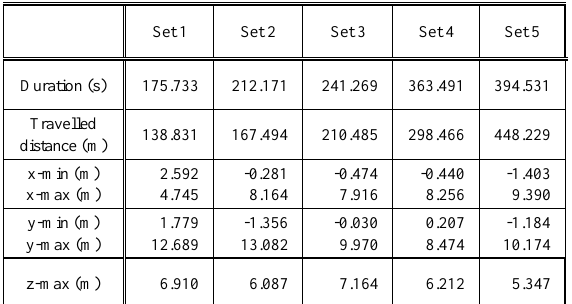
Table 1. Description of the acquired datasets